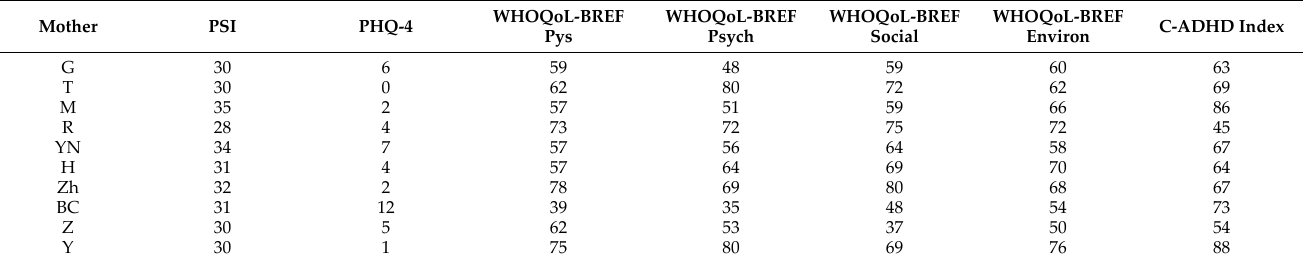
Table 2. Participants’ characteristics regarding self‑reported parenting stress, psychological symp‑ toms, quality of life, and severity of child ADHD symptoms ( n =